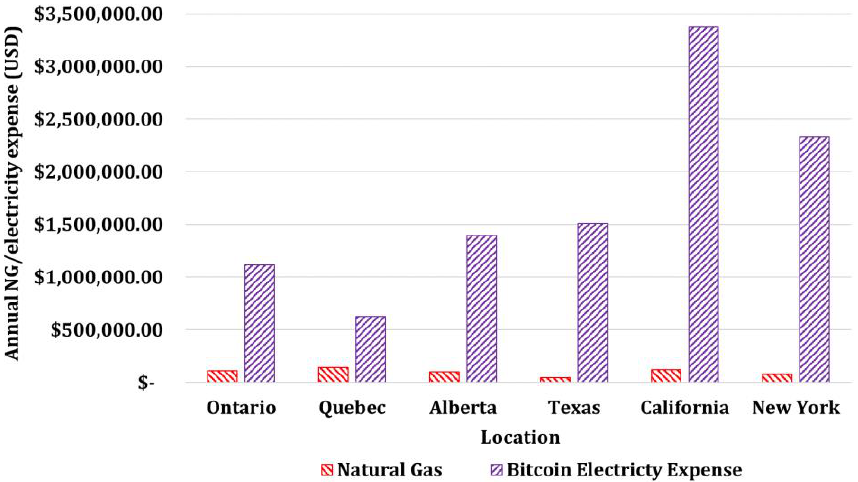
Figure 33. Annual heating expense of natural gas compared to electricity used to operate Bitcoin mining sources in six North American locations to heat Greenhouse 3.